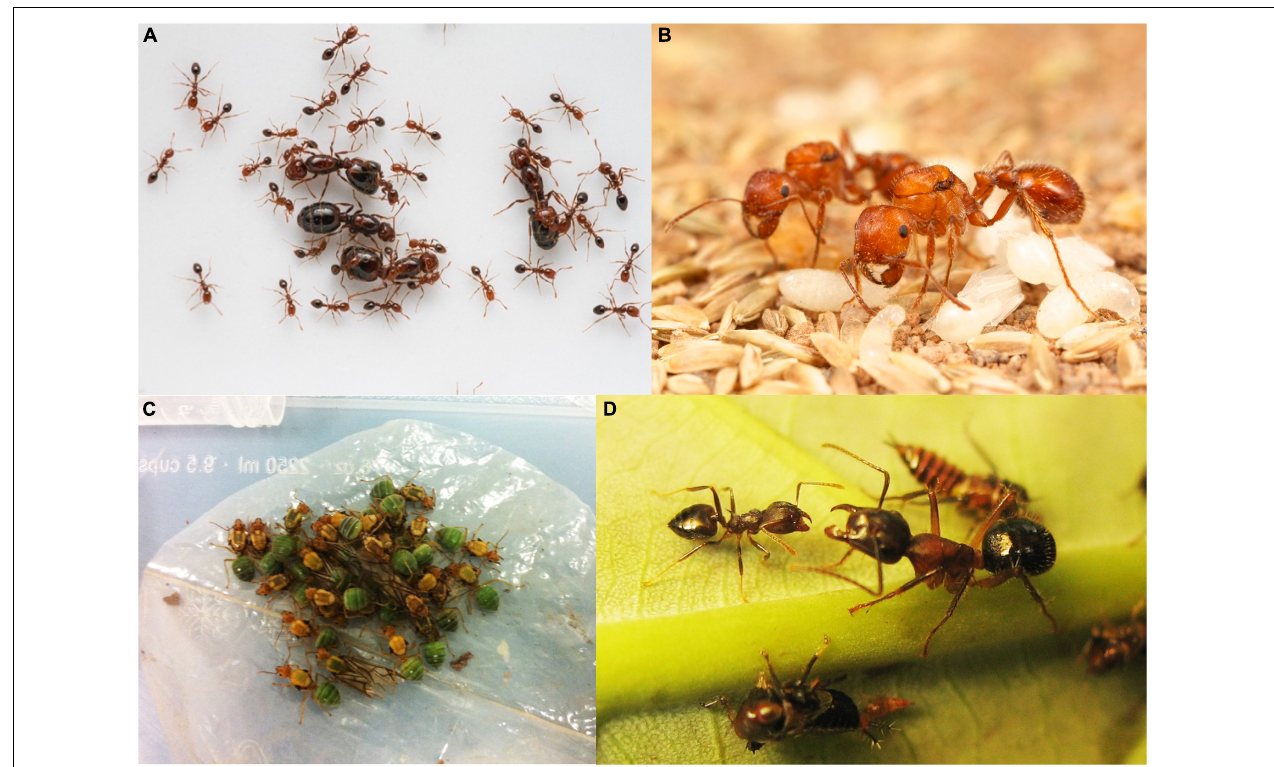
FIGURE 1 | Examples of ants that exhibit non-kin associations or variation in queen number along a continuum of relatedness. (A) Solenopsis invicta queens form polygyne colonies consisting of unrelated queens (photo credit: Haolin Zeng). (B) Pogonomyrmex californicus queens from a polygynous population (photo credit: Elizabeth Cash). (C) An association of over 20 Oecophylla smaragdina collected in Darwin, Australia from a rolled leaf where they had enclosed themselves (photo credit: Andrew Suarez). (D) Trophilaxis between Camponotus and Crematogaster workers in a parabiotic relationship in Malaysia (photo credit: Florian